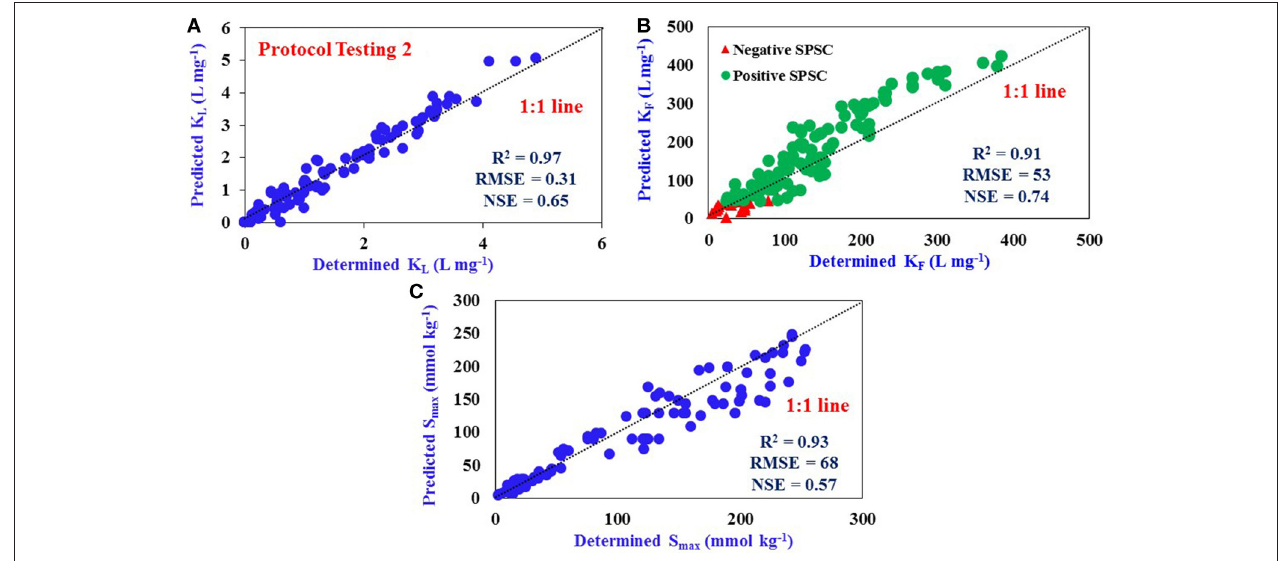
FIGURE 5 | Comparison of determined and predicted values: (A) Langmuir K L ( R 2 = 0.97 ), (B) Freundlich K F ( R 2 = 0.91 ), and (C) P Sorption Maximum, S max ( R 2 = 0.93 ) for various other locations within Sites 1–7 using predictive equations developed from Sites 1–4 data in a previous year. Dotted line represents 1:1 linear correlation. The number of samples used for Protocol Testing 2 is 135 ( n = 135 ). The data represent samples from all three horizons.